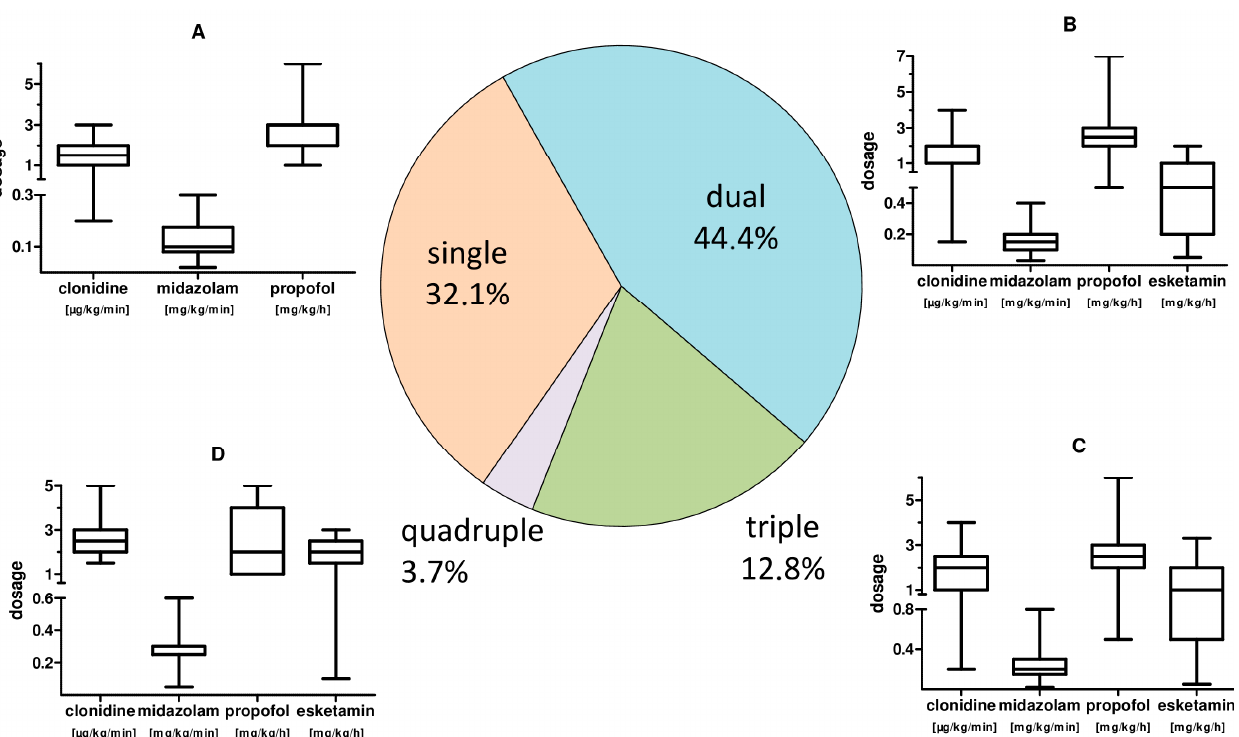
Figure 3. CARDS patient sedation: frequency of combined use and sedative dosages. Pie chart of the frequency of combined application of sedatives and, by analogy, the corresponding applied substance dosages. ( A ): box plot whisker plot of the sedation for single treatment. ( B ): box plot whisker plot of the individual sedation dosage for combined use of two sedatives. ( C ): box plot whisker plot of the individual sedation dosages for triple use of sedatives. ( D ): box plot whisker plot of the individual sedation dosages for quadruple use of sedatives.